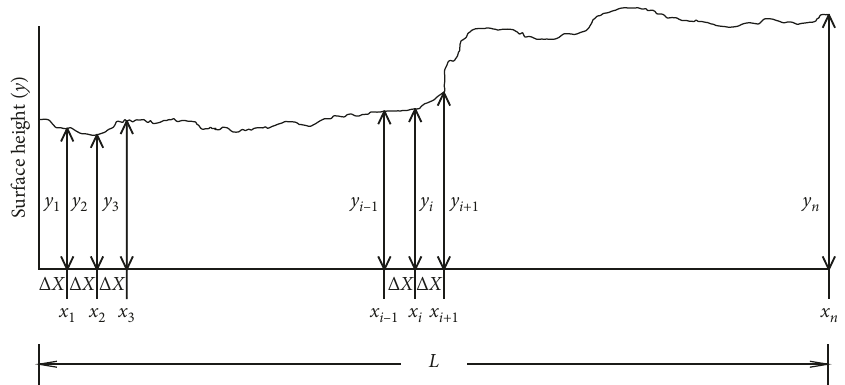
Figure 1: The diagram used to define geometric coordinates of a joint profile [23].